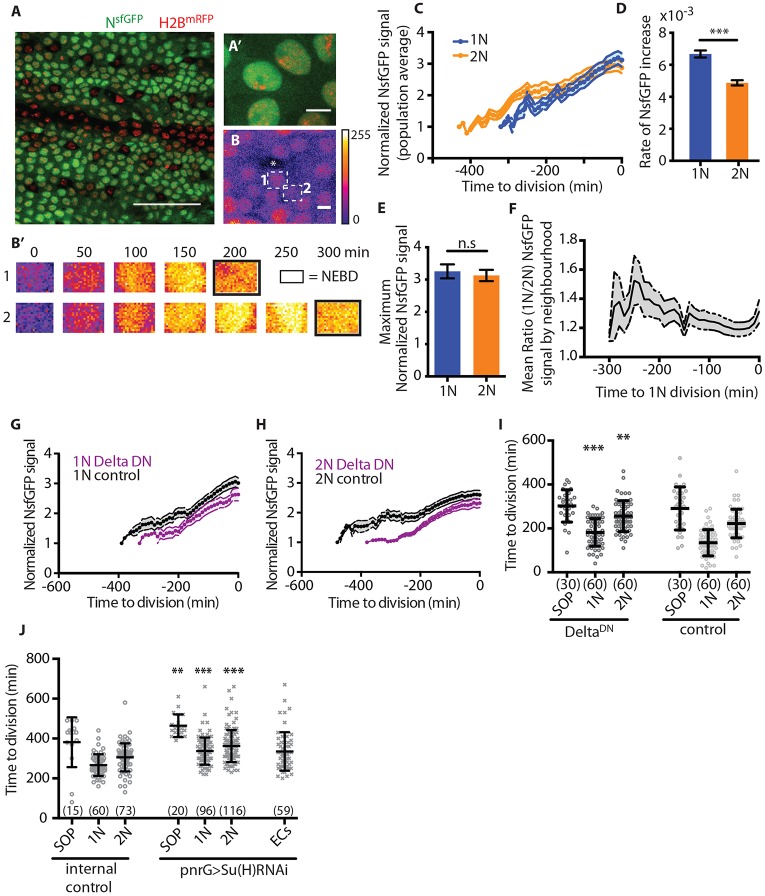
Cell division timing depends on Notch signalling. (A) NsfGFP expression pattern at 12 h AP. H2BmRFP labels nuclei. Scale bar: 50 µm. (A′) Higher magnification image of A. Scale bar: 5 µm. (B) False-coloured panel of NsfGFP -expressing ECs. Asterisk indicates SOP. Primary (1) and secondary (2) neighbours are indicated by dashed boxes. Scale bar: 5 µm. (B′) Time series of nuclear ROIs for cells 1 and 2 until nuclear envelope breakdown (NEBD; indicated by black boxes), leading to transient depletion of signal. (C) NsfGFP dynamics in ECs (n=29 each, N=3). (D) Rate of NsfGFP increase for the data shown in C. (E) Maximum normalized NsfGFP signal for the data shown in C. (F) Mean ratio of local SOP neighbourhood NsfGFP signal (n=27 SOP, 133 each EC type; N=3). (G-I) neur-GAL4 expression of DeltaDN reduces Notch signalling in wild-type 1N (G) or 2N (H) cells (n=16, N=2) versus control (UAS-lifeActRuby, n=30, N=3) and delays cell division timing in ShotgunGFP; neu-GAL4, UAS-GMCA>UAS-DeltaDN pupae (I) (N=3). (J) Cell division timing in ShotgunGFP; pnrGAL4>UAS-Su(H) RNAi pupae relative to control (N=2). ECs, epithelial cells in regions lacking differentiating SOPs. Mean±s.e.m. for C,F,G,H; mean±s.d. for D,E,I,J. n.s., not significant; **P<0.01; ***P<0.0001 by unpaired, two-tailed, t-test as indicated compared with control of the same type (i.e. RNAi-1N to control-1N). (n)=number of cells.